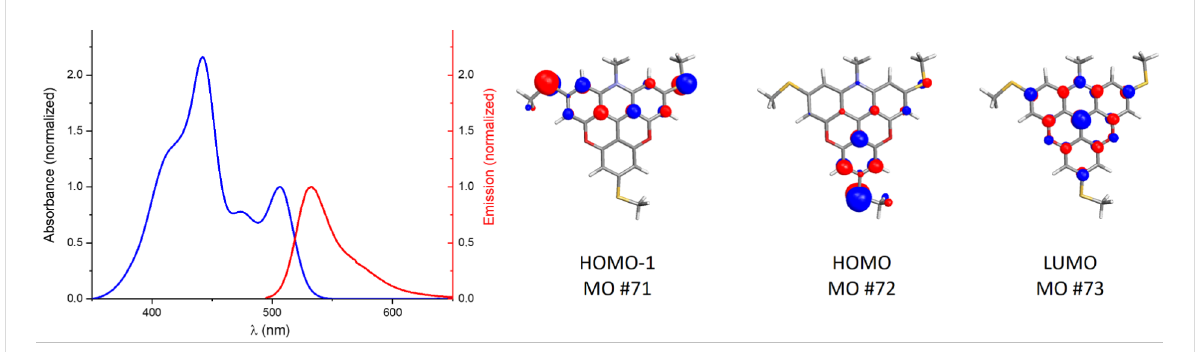
Figure 6: UV–vis absorption and fluorescence spectra ( λ ex = 485 nm) of 5a in CH 2 Cl 2 solution. Calculated molecular orbital contour plots (semi- empirical method AM1).